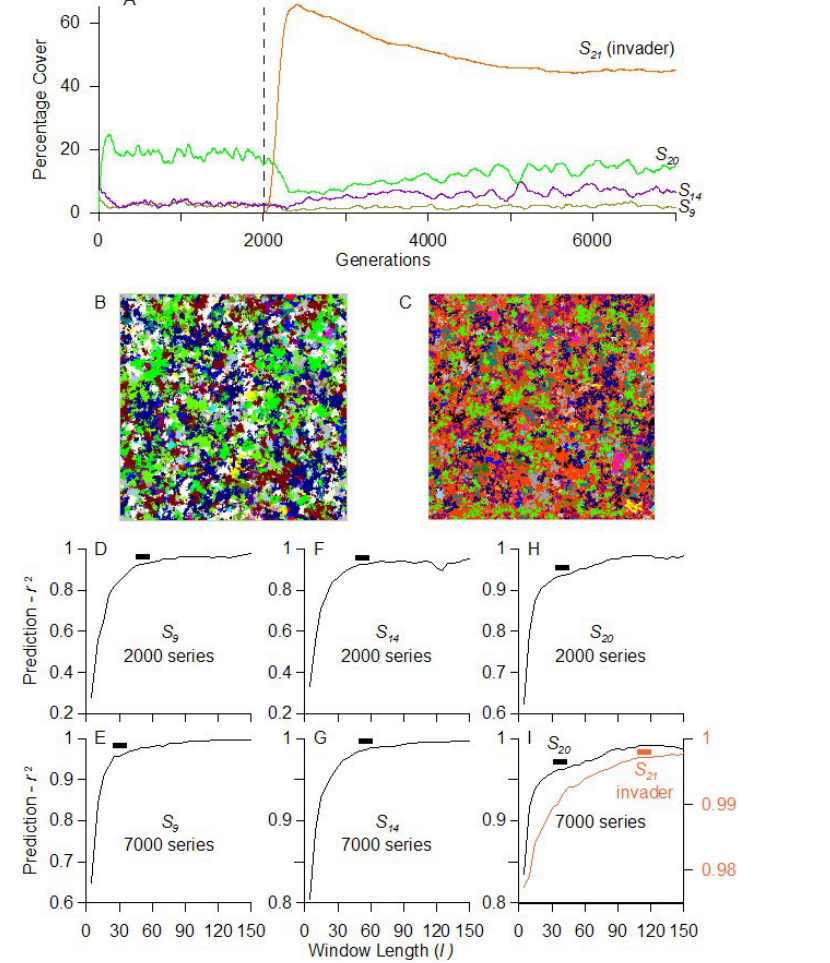
Fig. 6. Effects of an invading species (S = orange) on the CLS of the 20-species system. (A) Temporal 21 dynamics of three of the 20 species (S , S , S ) and the invader (S ). Up to generation 2000, all 20 9 14 20 21 species coexist and community structure is approximately constant because “open” recruitment enables recruits of all species to establish (with equal likelihood) on small patches on the landscape cleared by a low level of disturbance (see Methods). At generation 2001, the invader is introduced, which is able to overgrow three of the more abundant species, but interactions with all other species are standoffs. The invader attains an equilibrium of ca. 45% cover. (B) and (C) are examples of the landscape at approximately constant community compositions at 2000 and 7000 generations, respectively. Prediction-r 2 spectra are shown for analyses based on series of five maps, each 10 time steps apart, finishing at generation 2000 and 7000 (termed the “2000 series”and “7000 series,” respectively). Analyses based on densities of S indicate a reduction in the CLS from about 50 to about 30 length units 9 after the invasion (D and E, respectively), but the CLS indicated from analysis of densities of species S 14 (F and G), and S (H and I) show little change. The CLS indicated from analysis of densities of the 20 invader at around 7000 generations is much larger at about 115 length units (I). Areas identifying the CLS are shown as black horizontal